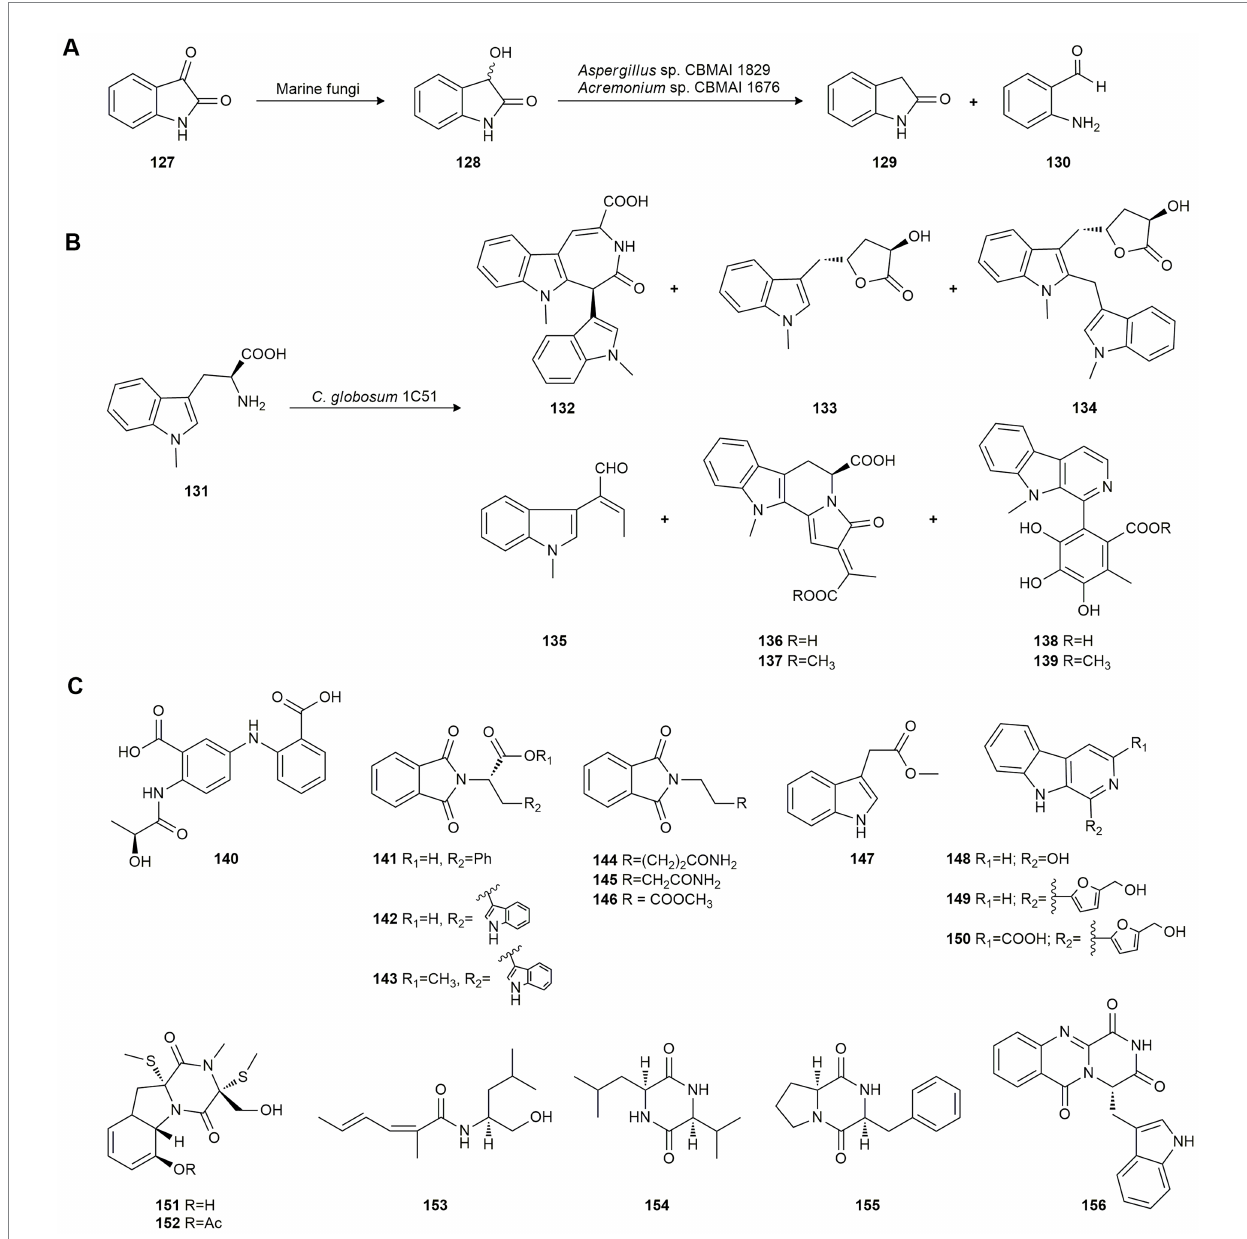
FIGURE 6 Biotransformations of other natural products. (A) Isatin ( 127 ) biotransformation by marine fungi (Birolli et al., 2017). (B) 1-Methyl- l -tryptophan ( 141 ) biotransformation by Chaetomium. globosum 1C51 (Yan et al., 2019). (C) Biotransformation products of a mixture of anthranilic acid and phthalimide by Scedosporium apiospermum F41-1 (Chen et al.,